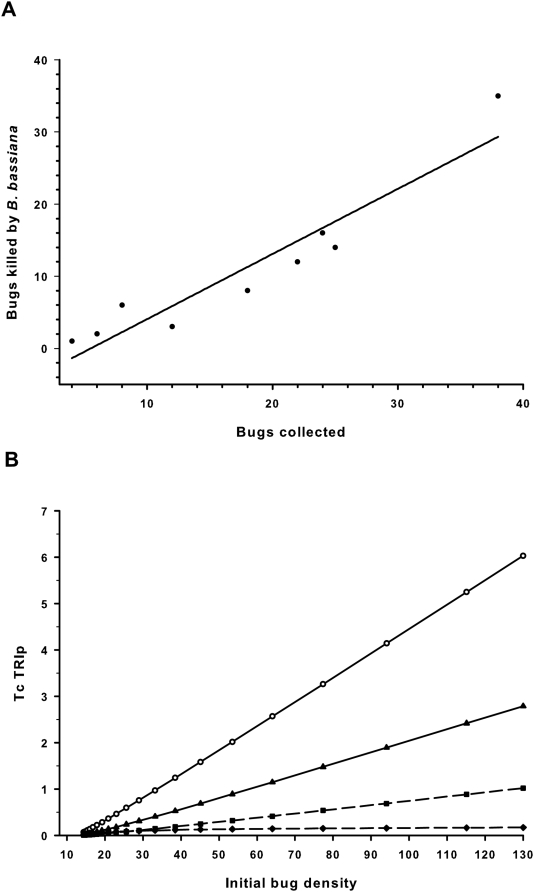
Efficacy of fungal intervention in rural villages, and estimation of bug population reduction on potential transmission risk.A) Relationship between the number of insects collected and the number of insects killed by B. bassiana after the intervention. The field experiment was performed in 9 houses from two rural villages in the Argentina/Bolivia border (Fig. S1A). Insects were collected manually, no chemical-trapping methodologies were used in order to avoid potential alterations in the process of fungal infection, and therefore they account for a small number of the actual catchable bug population. Adults were 40.3±7.0% of the total insects collected; 57.1±10.4% of the adults, and 55.1±10.4% of the nymphs were killed by fungi. Most of the nymphs collected (67.6%) belonged to fourth- and fifth-instar. These stages, along with adults, account for almost all bugs that are infected [28]. Linear regression: y = −4.98+0.90 x; r = 0.95. B) Estimation of potential T. cruzi transmission risk index (TcTRIp) after intervention with B. bassiana-based traps at village level. Solid lines show the predicted TcTRIp [25] without intervention (circles), and after bug population reduction due to the experimental fungal infection shown in A) (triangles). Dotted lines indicate the predicted values of TcTRIp after 2 (squares) or 3 (diamonds) hypothetical successive interventions. Initial bug density corresponds to an arbitrary number of insects prior intervention.